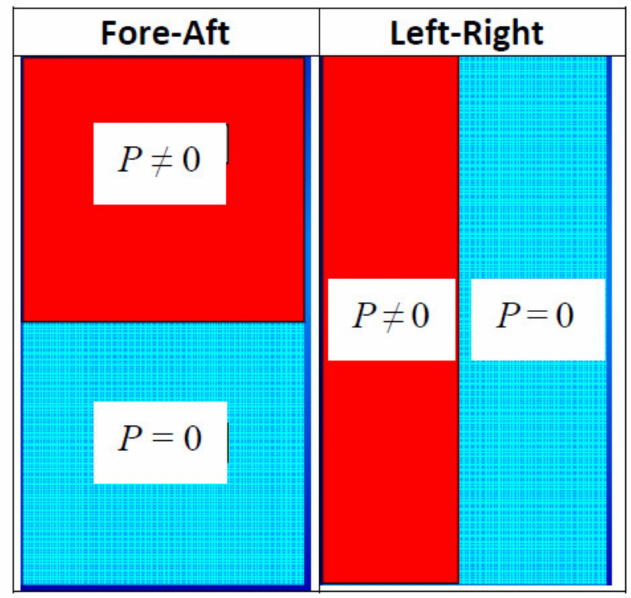
Figure 12. Asymmetric pressure distributions on the orthogrid